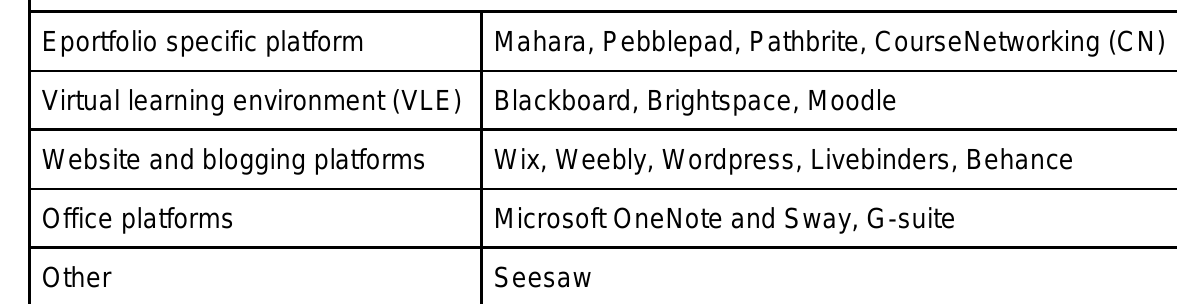
Table 4. Types of eportfolio platform